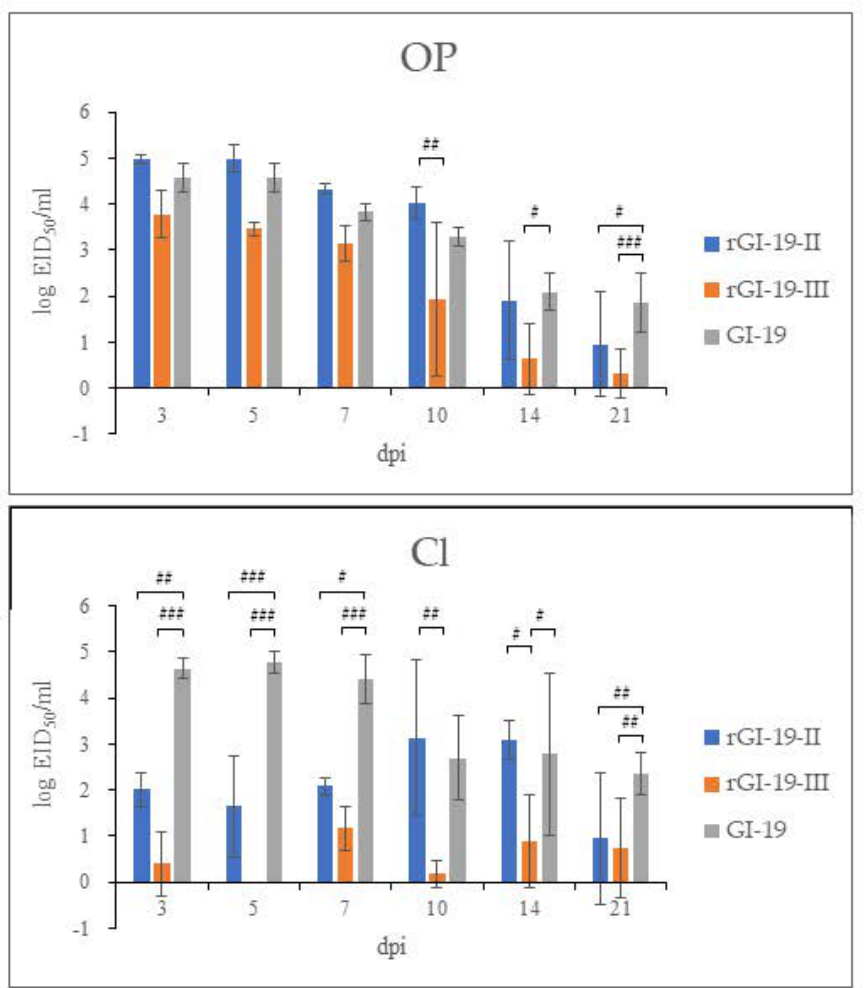
Figure 6. Mean viral shedding of infected IBVs, as measured by RT-qPCR. Each data point represents the IBV titer detected in oropharyngeal (OP) and cloacal (CL) swabs at different days post-infection (dpi). Bars represent the standard deviation of the mean. #: p < 0.05; ##: p < 0.01; ###: p <